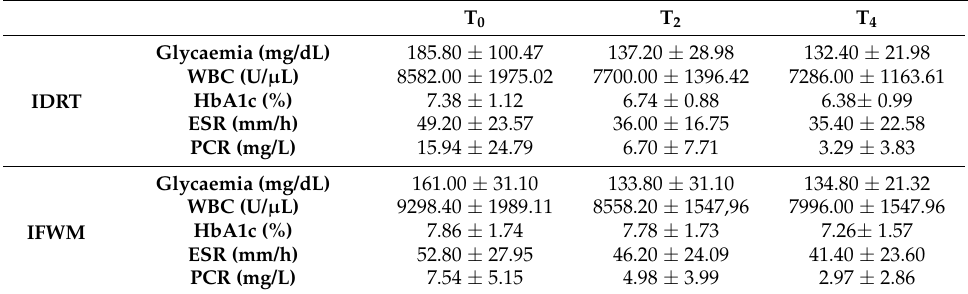
Table 4. Results of laboratory blood tests of IDRT and IFWM.